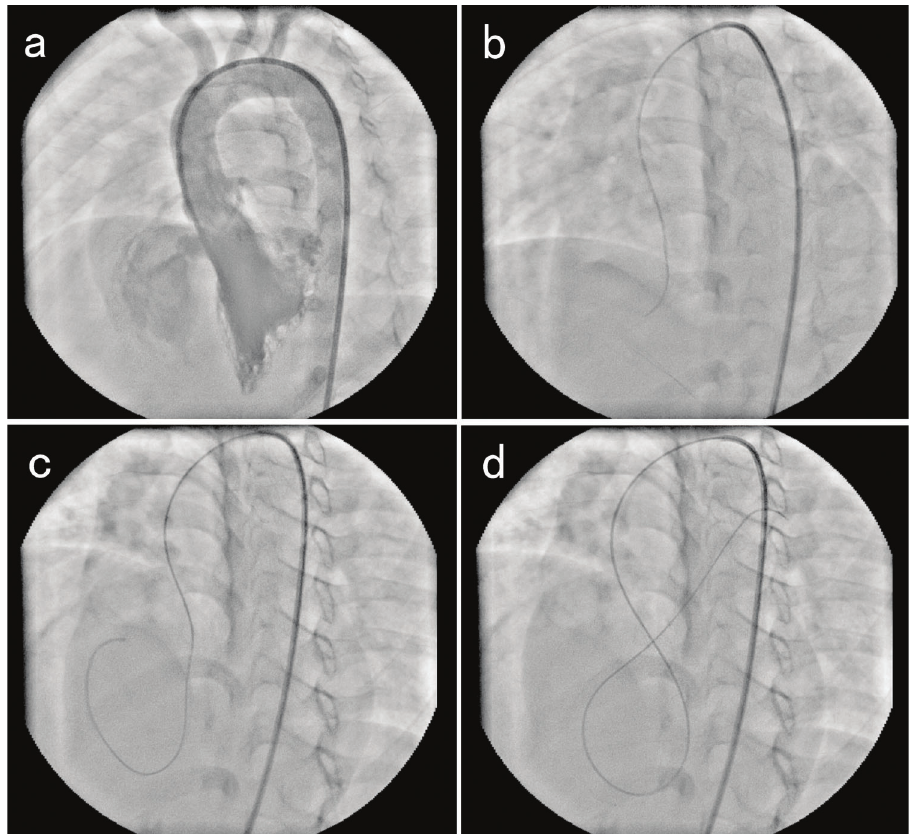
Figure 1 - The process of the wire-drifting technique a: Left ventricular angiography showing the PmVSD. The distance from the aortic valve to the upper edge of the defect was approximately 3 mm, and the diameter was approximately 6 mm. b: The catheter was in the aortic arch, and the guidewire was advanced along the catheter into the left ventricle. c: The guidewire drifted with the direction of flow through the defect to the right ventricle. d: The guidewire in the right ventricle drifted to the distal end of the pulmonary artery with the direction of